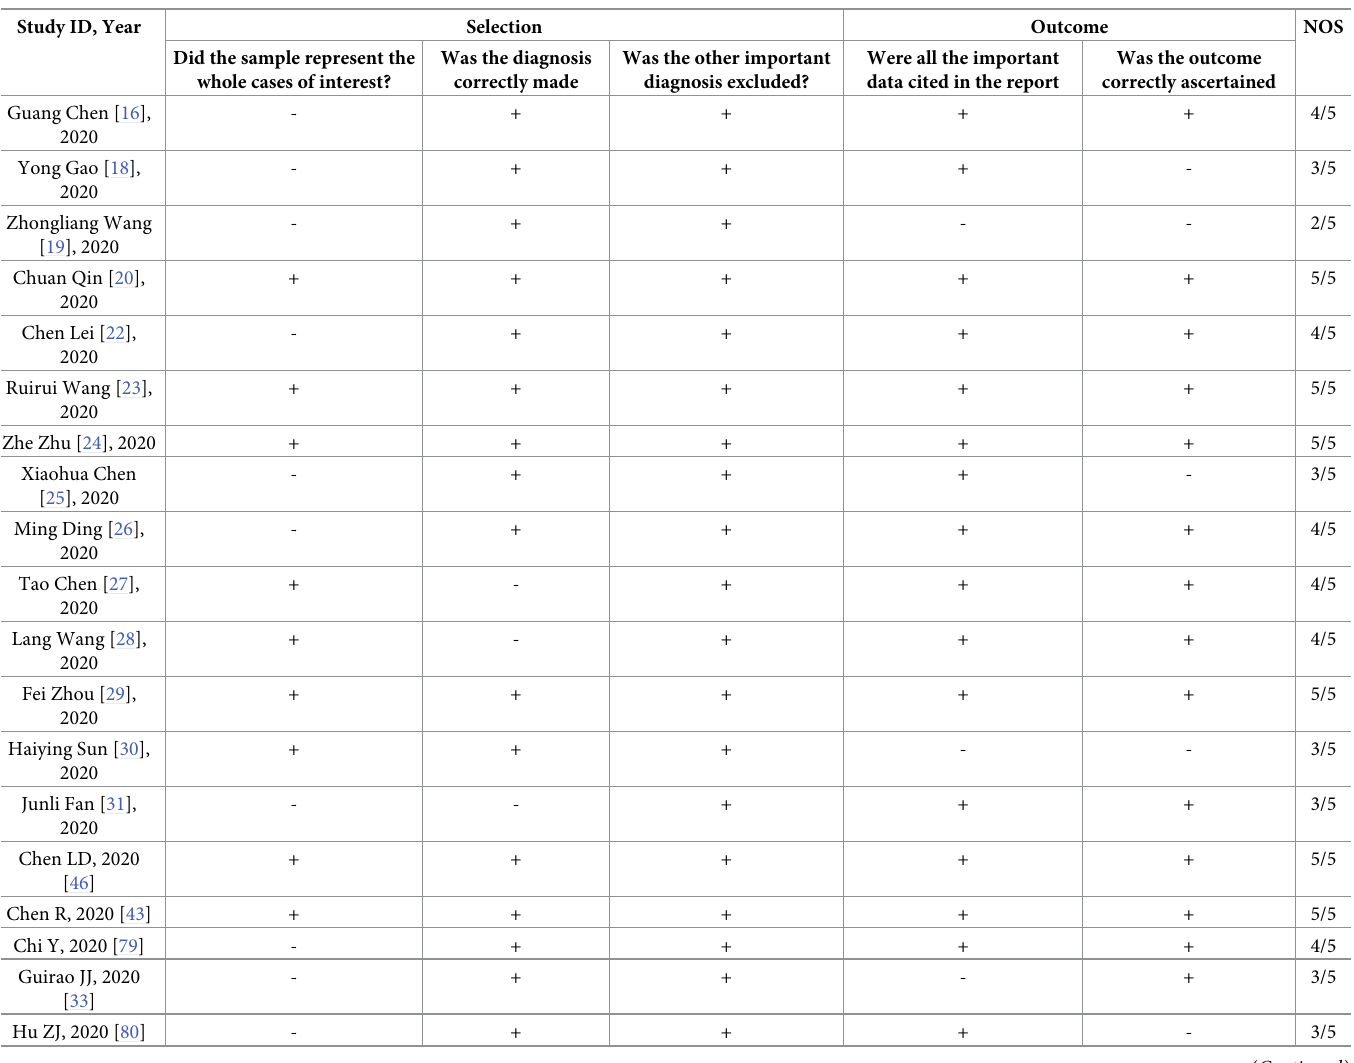
Table 2. Risk of bias assessment—Modified Newcastle-Ottawa Scale